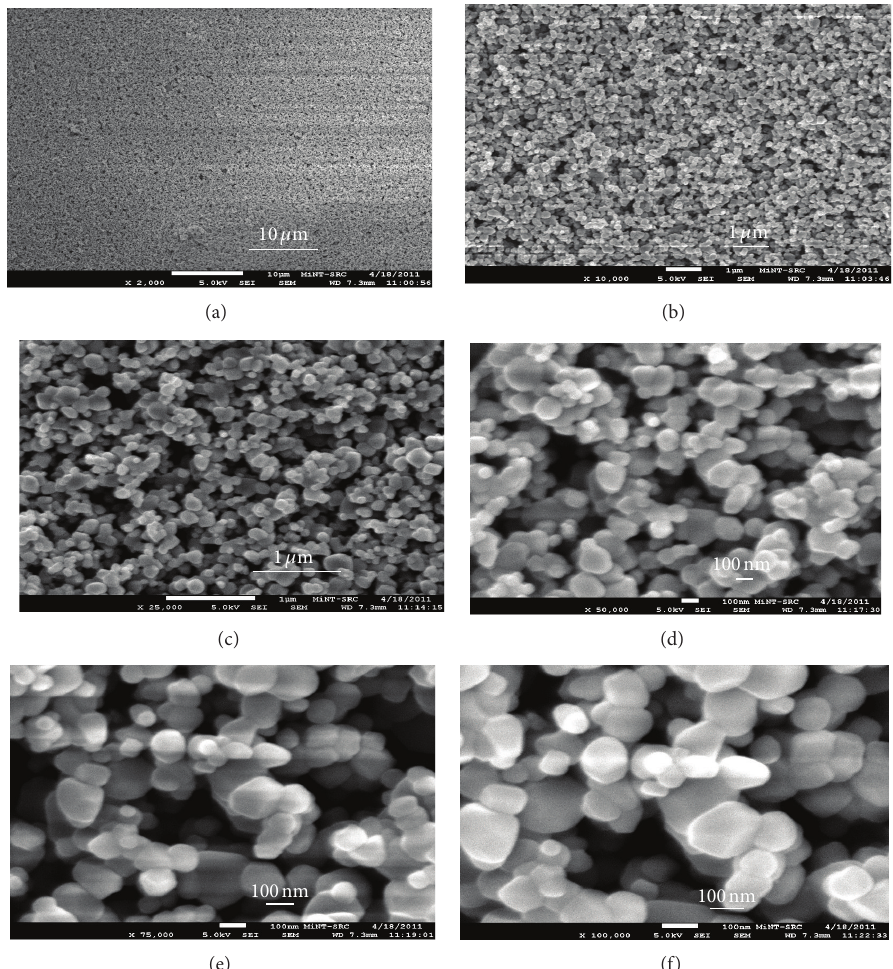
Figure 4: Metal oxide morphology with magnification for treated TiO 2 , (a) 2000, (b) 10000, (c) 25000, (d) 50000, (e) 75000, and (f) 100000.